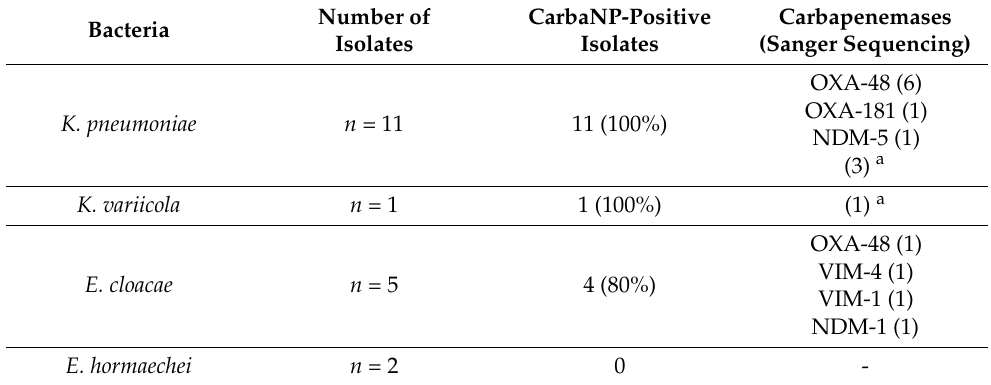
Table 2. Carbapenemases identified by Sanger sequencing in different multidrug-resistant GNB and the origin of each